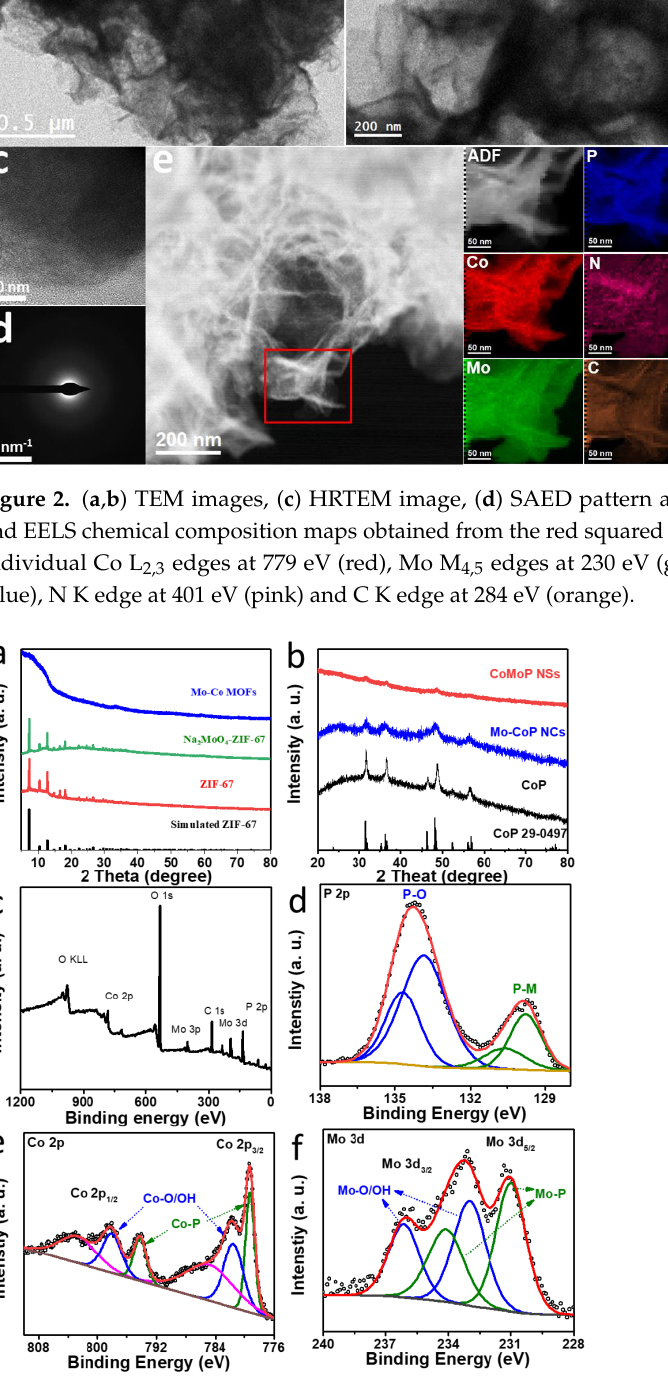
Figure 3. ( a , b ) XRD pattern of the MOFs ( a ) and the phosphorized materials, CoMoP, Mo–CoP and CoP. ( c – f ) XPS survey and high-resolution P 2p ( d ), Co 2p ( e ) and Mo 3d ( f ) XPS spectra of CoMoP.